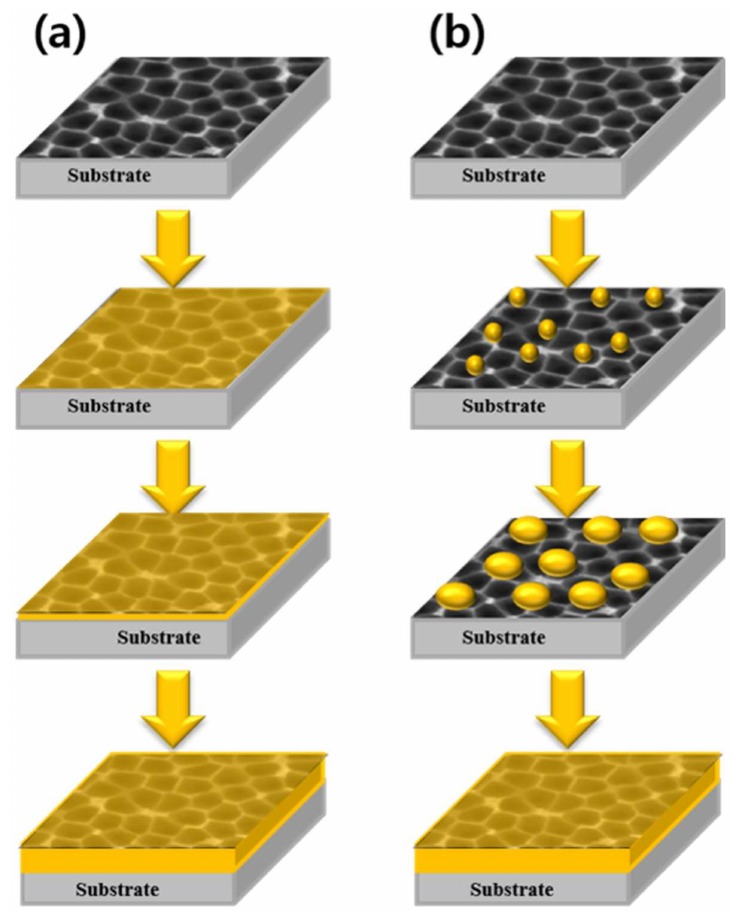
Figure 8. Schematic illustration of thin film growth based on ( a ) Frank-van der Merwe and ( b ) Volmer-weber